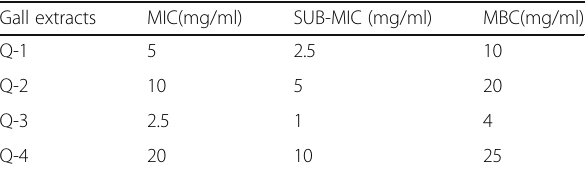
Table 1 Minimum inhibitory concentrations (MICs), Sub-MICs, and Minimum Bactericidal Concentrations (MBCs) of Q. infectoria gall extracts of MDR P. aeruginosa isolates (mg/ml)